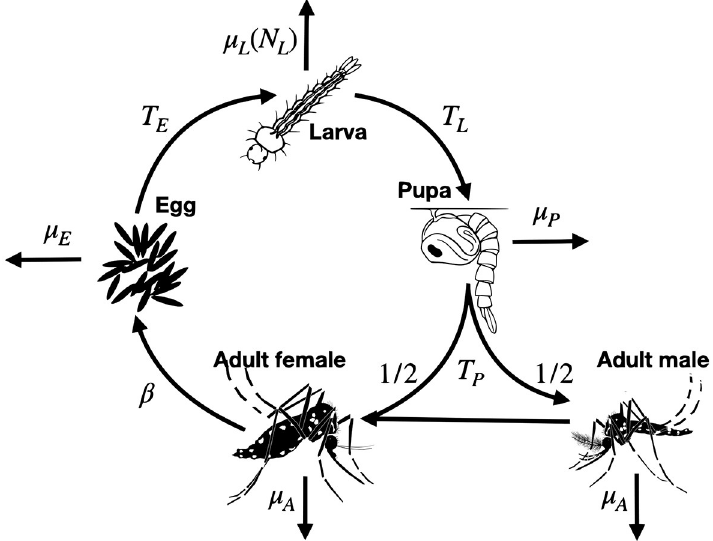
Fig 1. The lumped age-class model of mosquito life history. Mosquitoes are divided into four life stages: egg, larva, pupa and adult. The durations of the sub-adult stages are T , T and T for eggs, larvae and pupae, respectively. Sex is E L P modeled at the adult stage, with half of pupae developing into females and half developing into males. Daily mortality rates vary by life stage— μ , μ , μ and μ for eggs, larvae, pupae and adults, respectively. Density-dependent mortality E L P A occurs at the larval stage and is a function of the total number of larvae, N L . Females mate once upon emergence, and retain the genetic material from that mating event for the remainder of their lives. Males mate at a rate equal to the female emergence rate. Females lay eggs at a rate, β .